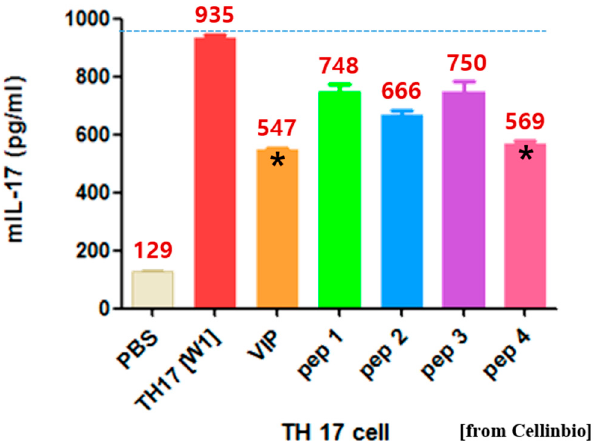
Figure 3. Anti-inflammatory effect of the four peptide candidates in a T H 17 cell differentiation inhibition model. The results show that tIK-yk4 (pep 4), composed of 18 amino acids, shows an anti- inflammatory effect comparable to vasoactive intestinal peptide (VIP). Both are marked with